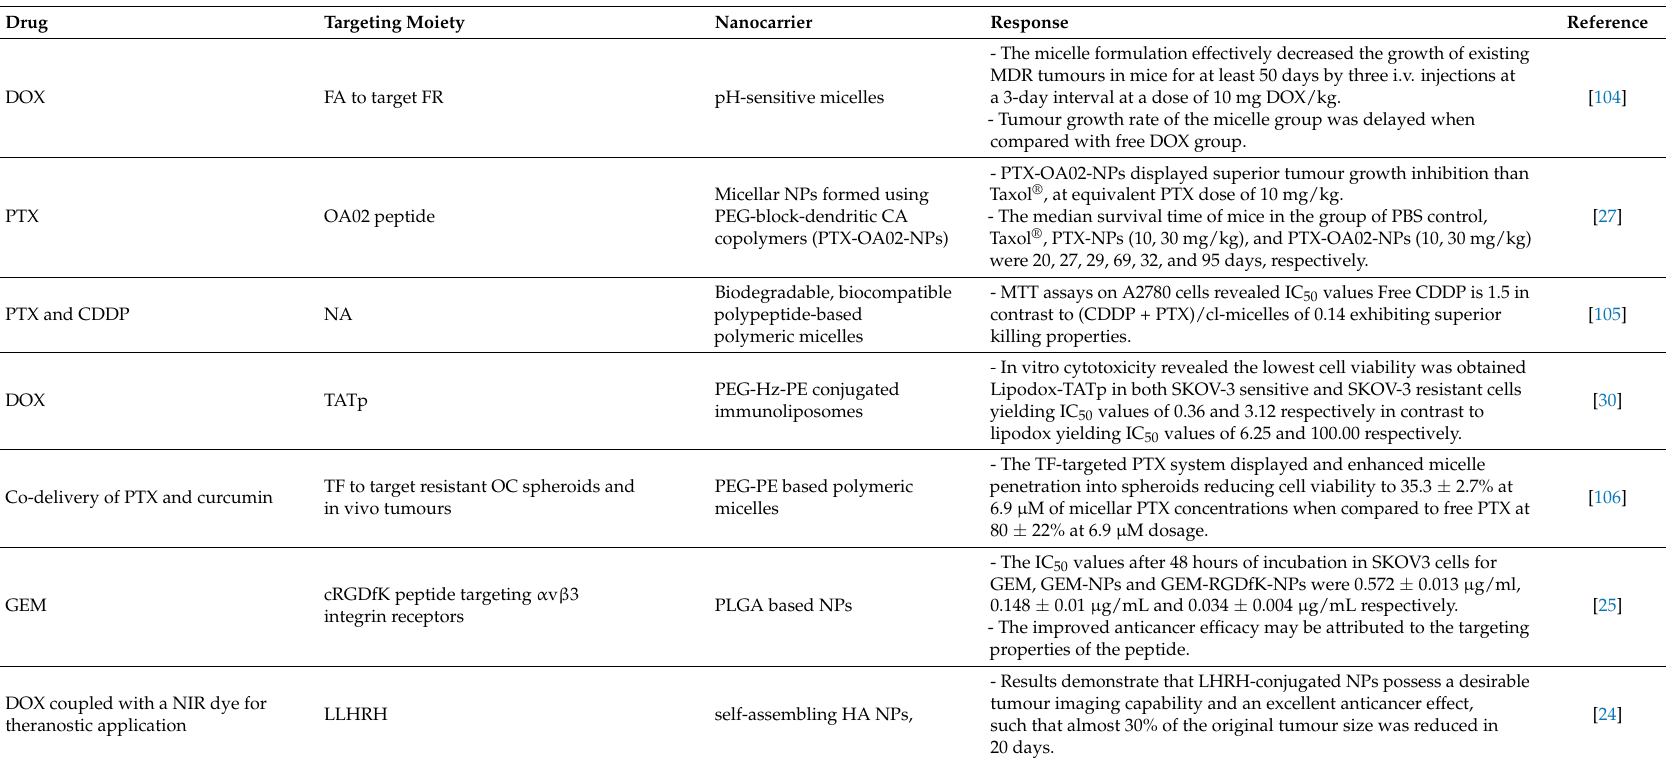
Abbreviations in the table are defined as follows: PTX, paclitaxel; i.v., intravenous; PEG, polyethylene glycol; CA, cholic acid; CDDP, cis-dichlorodiamminoplatinum; TATp, transactivator of transcription peptide; PEG-Hz-PE, Polyethylene glycol–Hydrazine–phosphatidylethanolamine; TF, Transferrin; PEG-PE , polyethylene glycol-phosphatidylethanolamine; GEM, Gemcitabine hydrochloride, PLGA, poly ( D , L -lactic-co-glycolic)